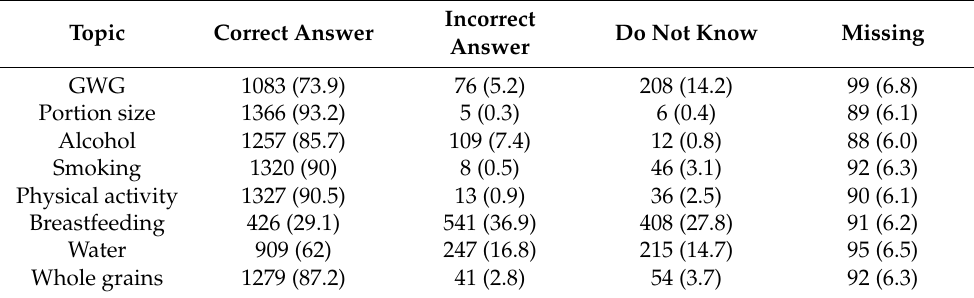
Table 3. Evaluation of questionnaire.